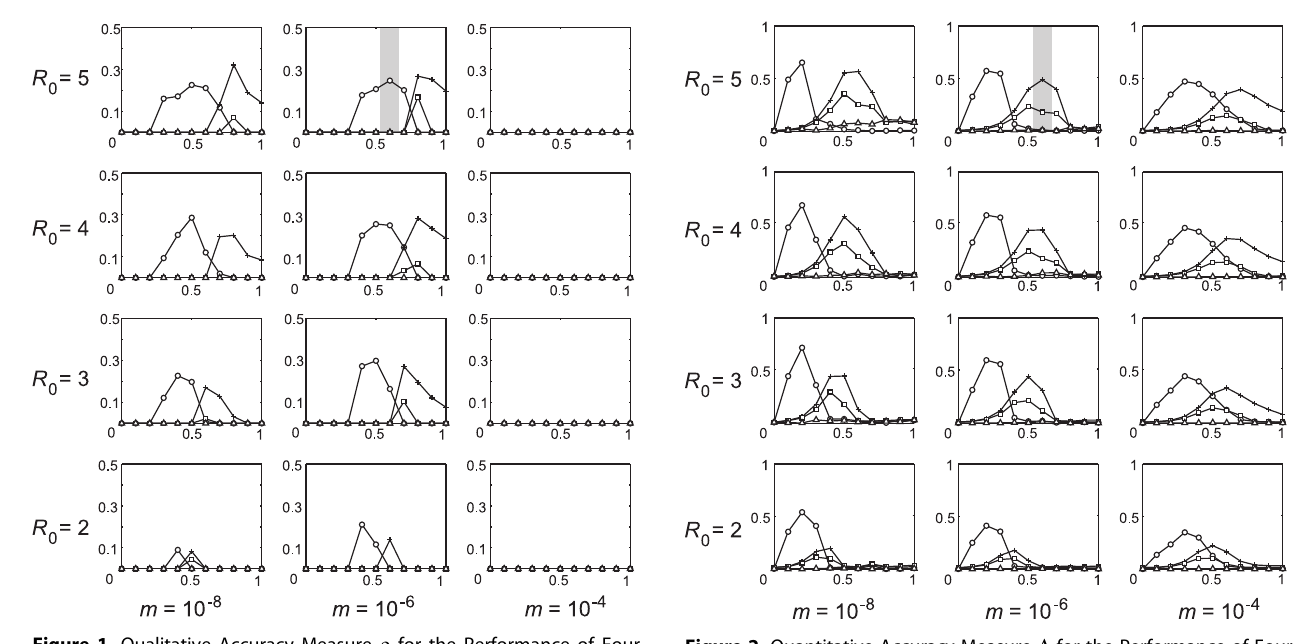
Figure 2. Quantitative Accuracy Measure D for the Performance of Four Models Details as in Figure 1.